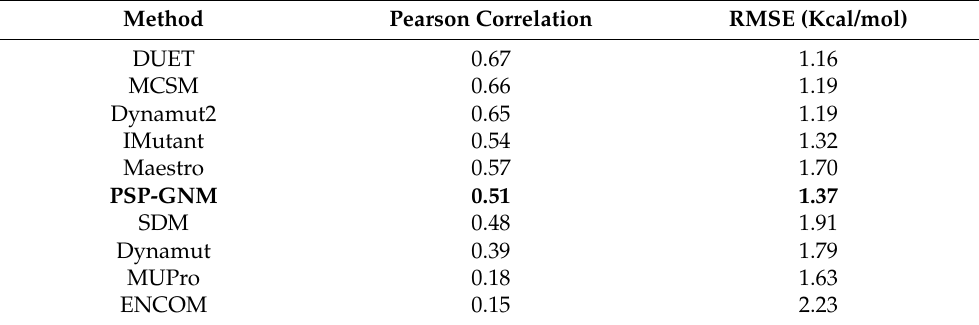
Table 3. Performance on the S350 dataset for a subset of 325 mutations with a PSP-GNM-calculated ∆∆ G. The 325 mutations had at least one contact broken, both in the wildtype and mutant forms, for the residue at the mutation position when simulating unfolding with PSP-GNM. The performance for PSP-GNM is shown in bold.